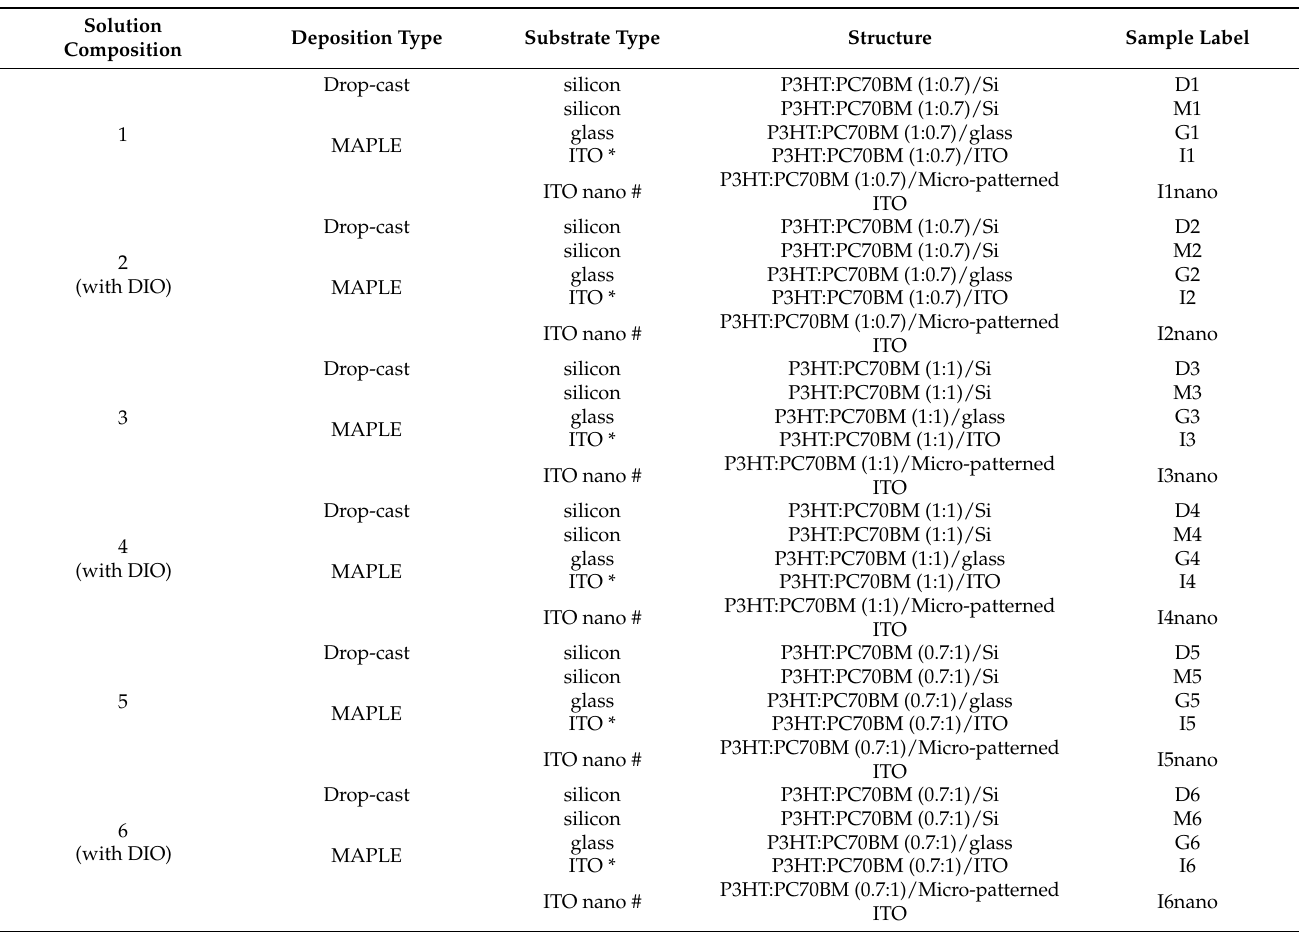
Table 2. Labels of the deposited organic